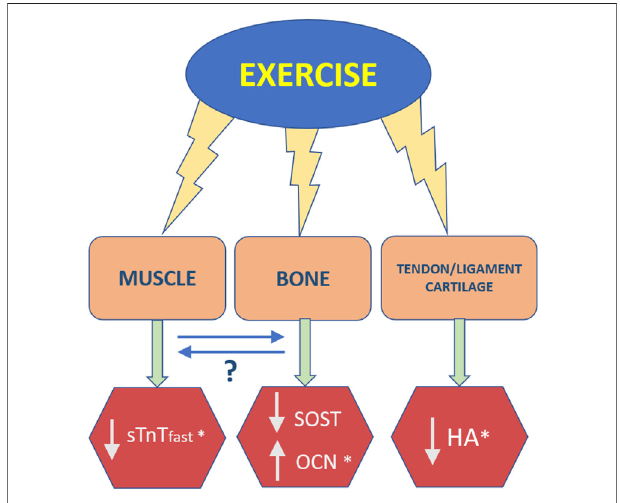
FIGURE 5 | Main effects of exercise on biomarkers associated with tissuesofthemusculoskeletalsystem,alsoshowingpotentialinterrelationship or crosstalk between muscle and